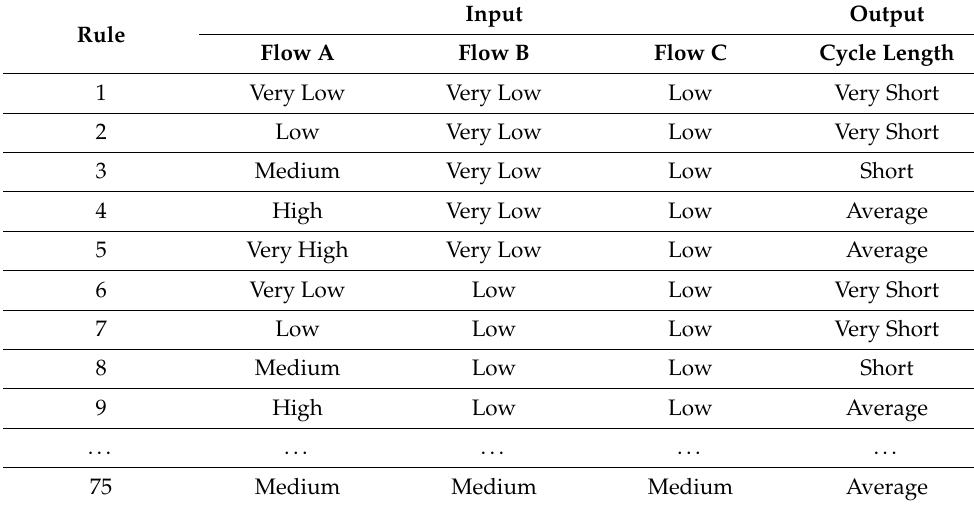
Table 1. Example of the if–then rules used for the fuzzy inference system.